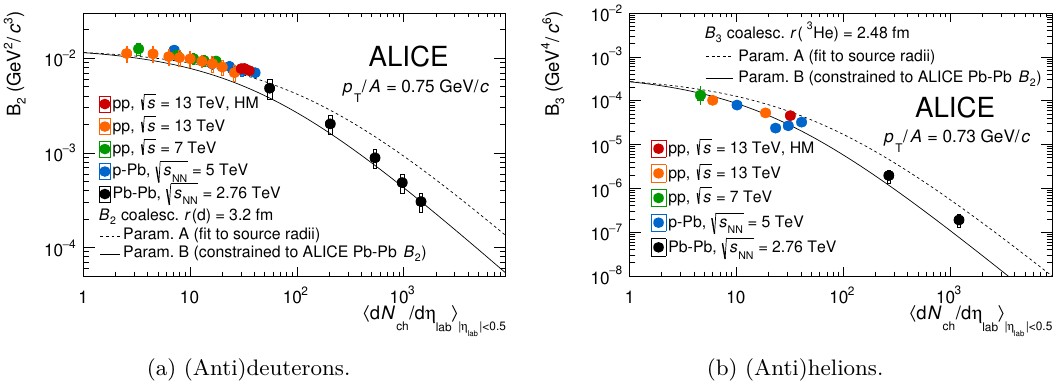
Figure 5. (a): B 2 at p T /A = 0.75 GeV/ c as a function of multiplicity in HM pp collisions at √ √ √ s = 13 TeV, in MB pp collisions at s = 13 TeV [17] and at s = 7 TeV [11], in p-Pb √ √ collisions at s NN = 5 . 02 TeV [15], and in Pb-Pb collisions at s NN = 2 . 76 TeV [10]. (b): B 3 at √ p T /A = 0.73 GeV / c as a function of multiplicity in HM pp collisions at s = 13 TeV, in MB pp √ √ collisions at s = 13 TeV, in p-Pb collisions at s NN = 5 . 02 TeV [15], and in Pb-Pb collisions at √ s NN = 2 . 76 TeV [10]. Vertical bars and boxes represent statistical and systematic uncertainties, respectively. The two lines are theoretical predictions based on two different parameterisations of the source